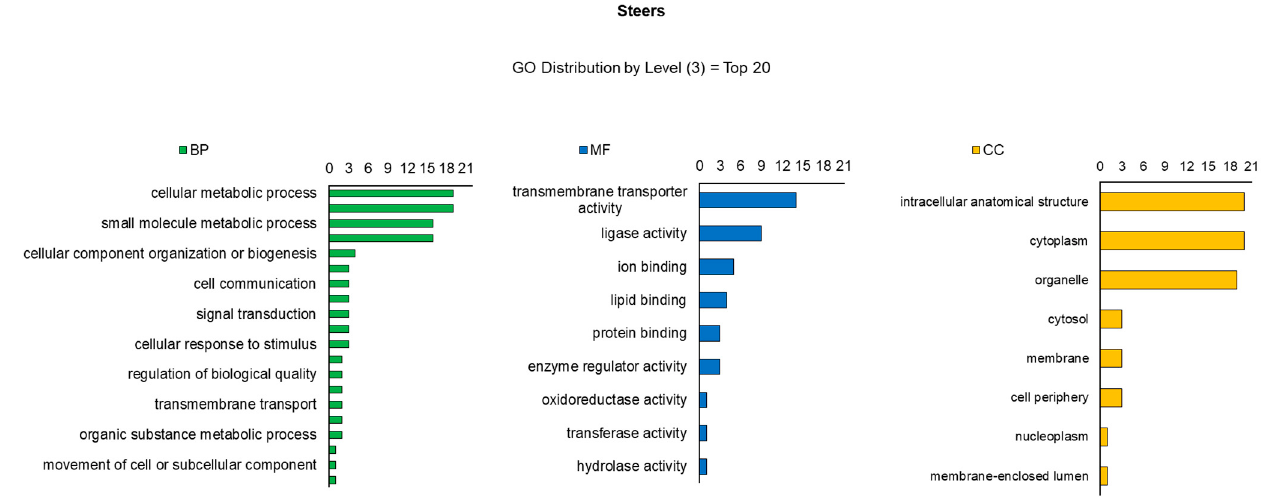
Figure 3. Classification of proteins identified in tissue samples ( Longissimus thoracis ) from immunocastrated F1 Montana-Nellore young heifers feedlot finished. The OMICSBOX software was used to classify the proteins according to biological process (BP), molecular function (MF), and cellular component (CC).